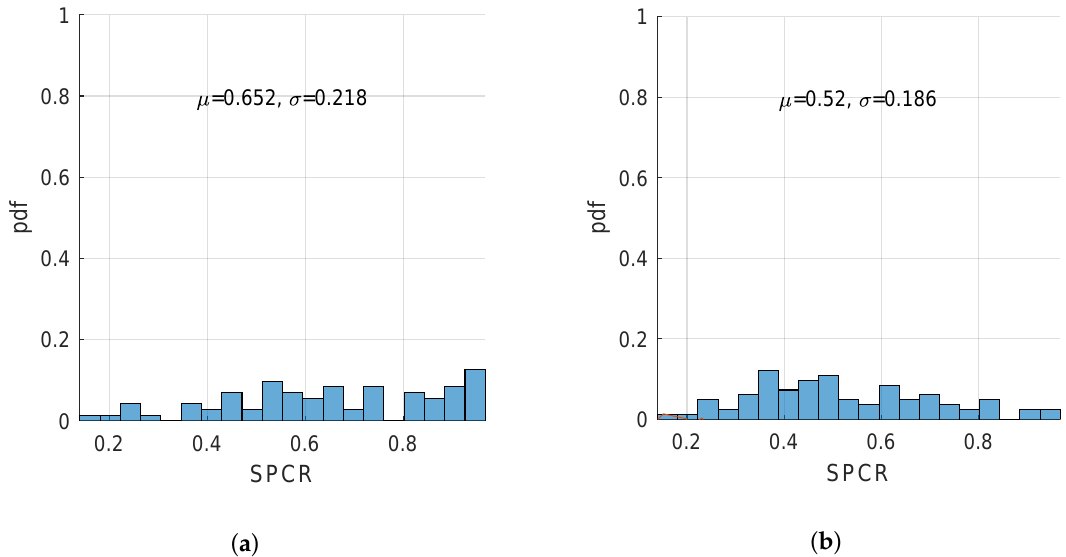
Figure 14. Distribution of the Signal Power Concentration Ratio (SPCR) across the patients in A2 and B2 groups. ( a ) A2 group—patients with essential tremor; ( b ) B2 group—patients with cervical dystonia.